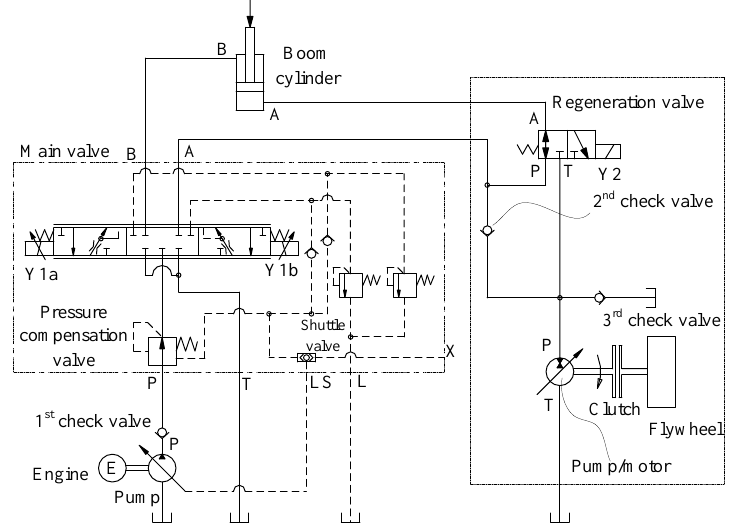
Figure 2. The proposed load sensing system with a flywheel-based energy recovery system. There are three working modes: regeneration mode, reutilization mode, and standby